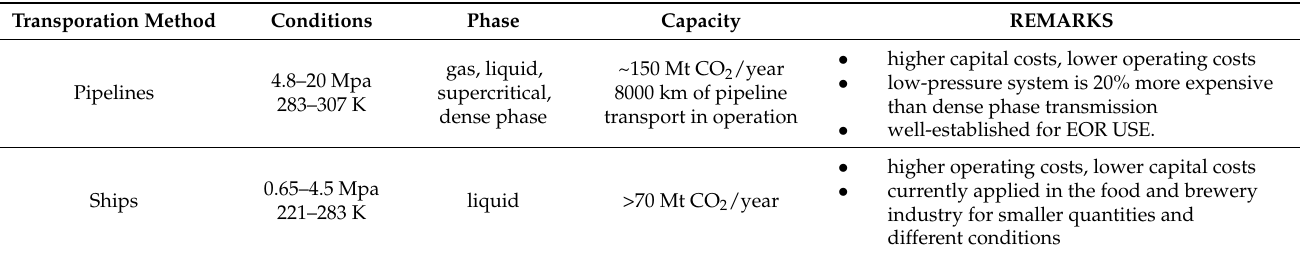
Table 3. Carbon Dioxide transportation alternatives